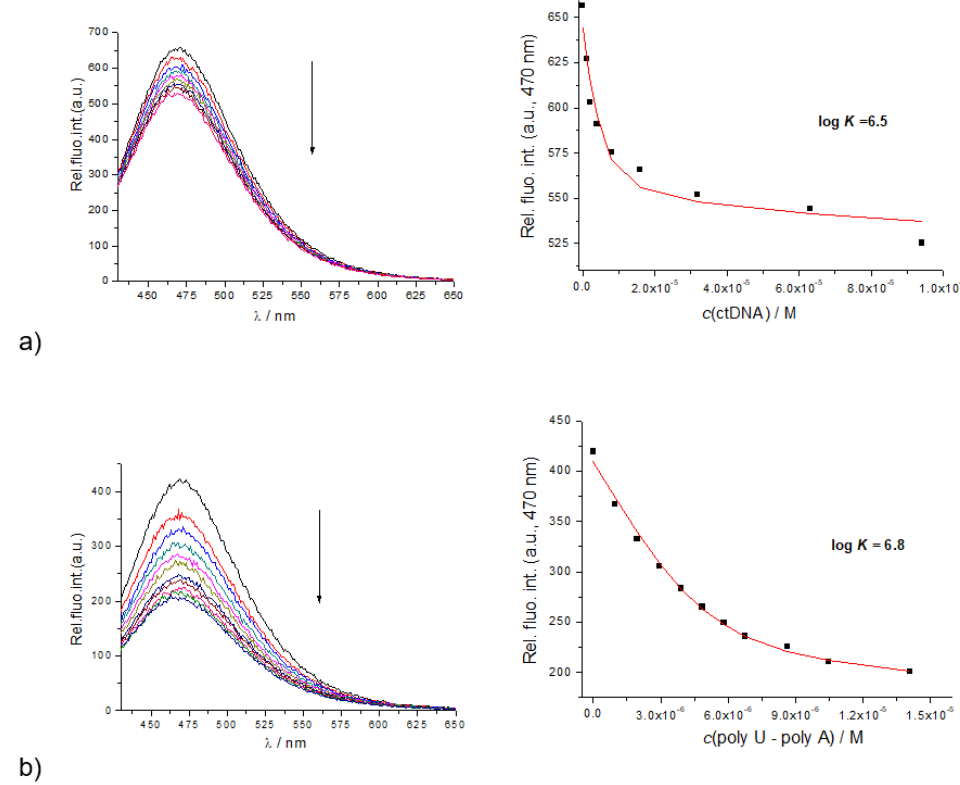
Figure 4. ( a ) Fluorimetric titrations of 6 ( c = 1 × 10 −6 M; λ exc = 350 nm) with a) ctDNA; ( b ) with poly A –poly. U. RIGHT: Dependence of emission intensity at λ max = 470 nm on c(polynucleotide), ( ▬ ) data fit to the Scatchard equation [46]. Performed at pH = 7.0, buffer sodium cacodylate, I = 0.05 M, 0.04% DMSO.